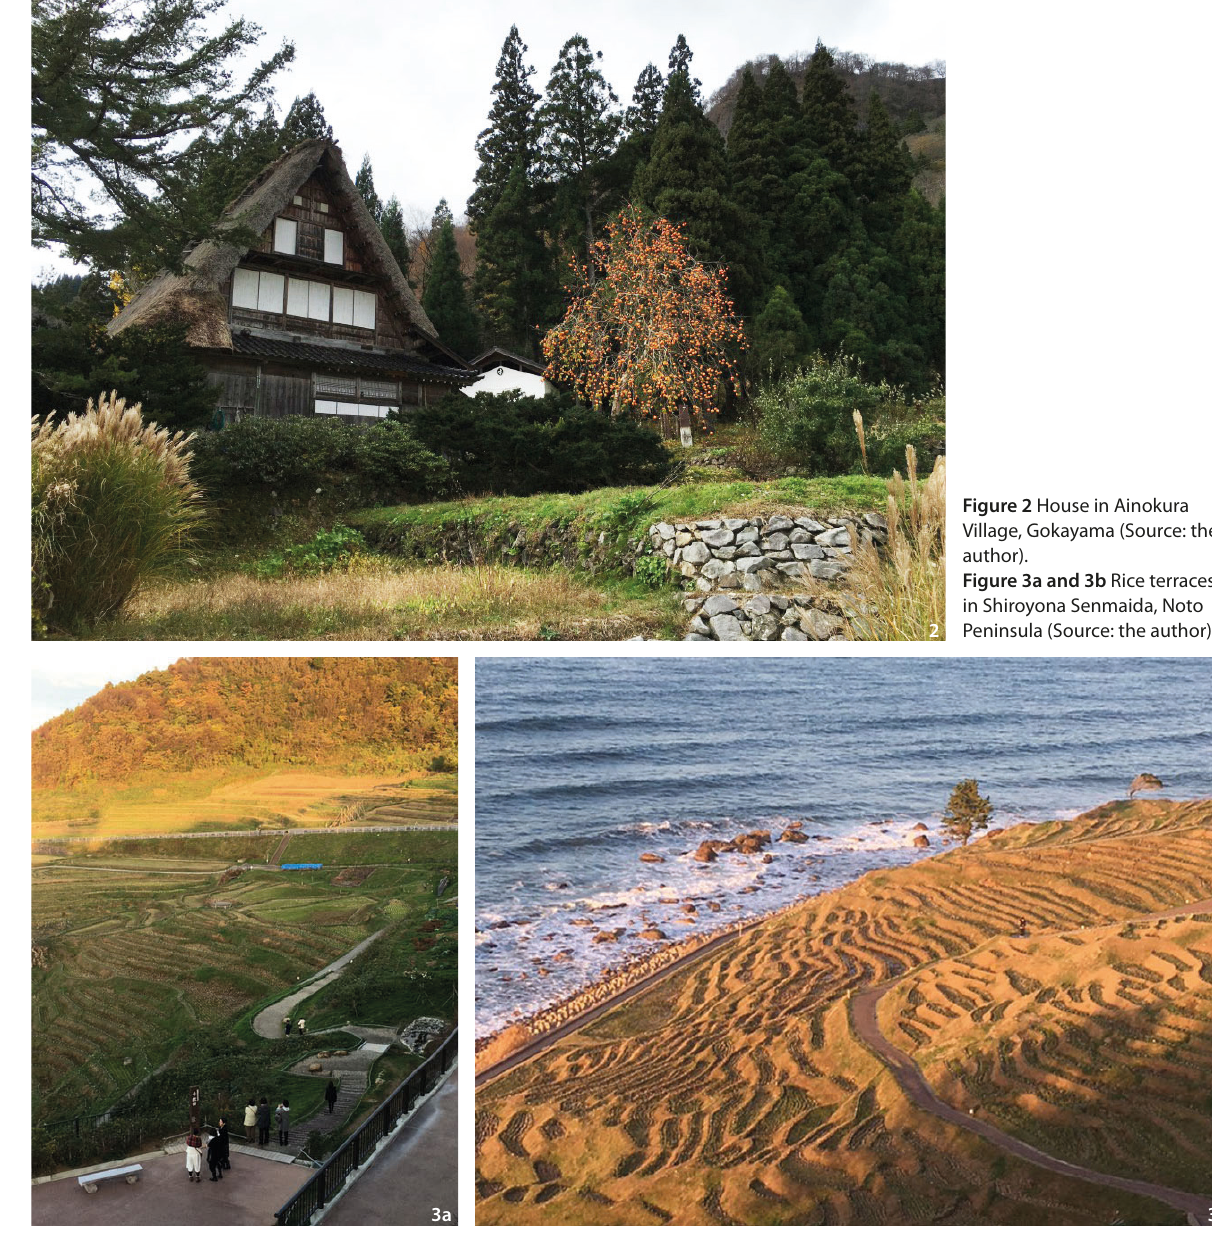
Figure 2 House in Ainokura Village, Gokayama (Source: the author). Figure 3a and 3b Rice